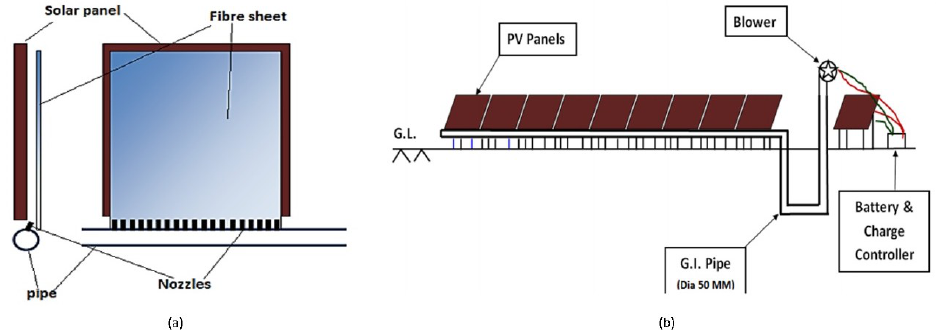
Figure 20. Arrangement of solar panel, fibre sheet and nozzles ( a ) and schematic design of Ground-Coupled Central Panel Cooling System (GC-CPCS) ( b ) [93].